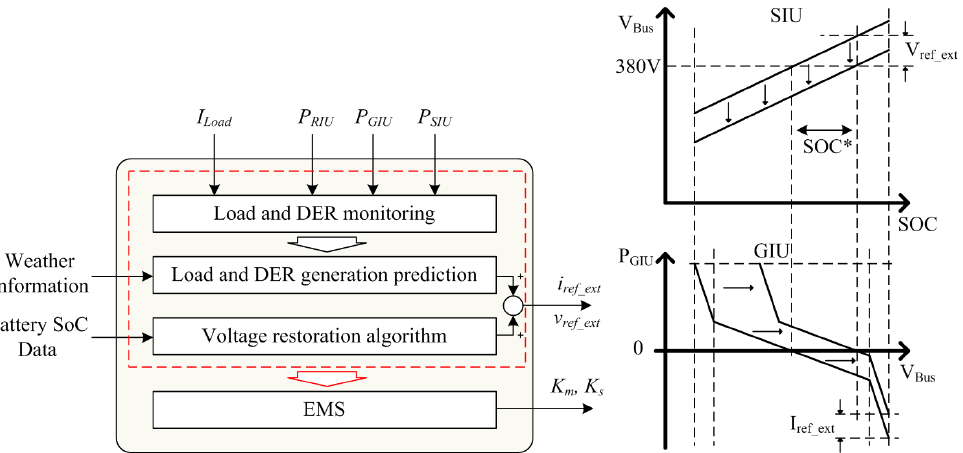
Figure 6. Central controller block diagram and DC bus voltage restoration concept of the proposed master–slave control method.